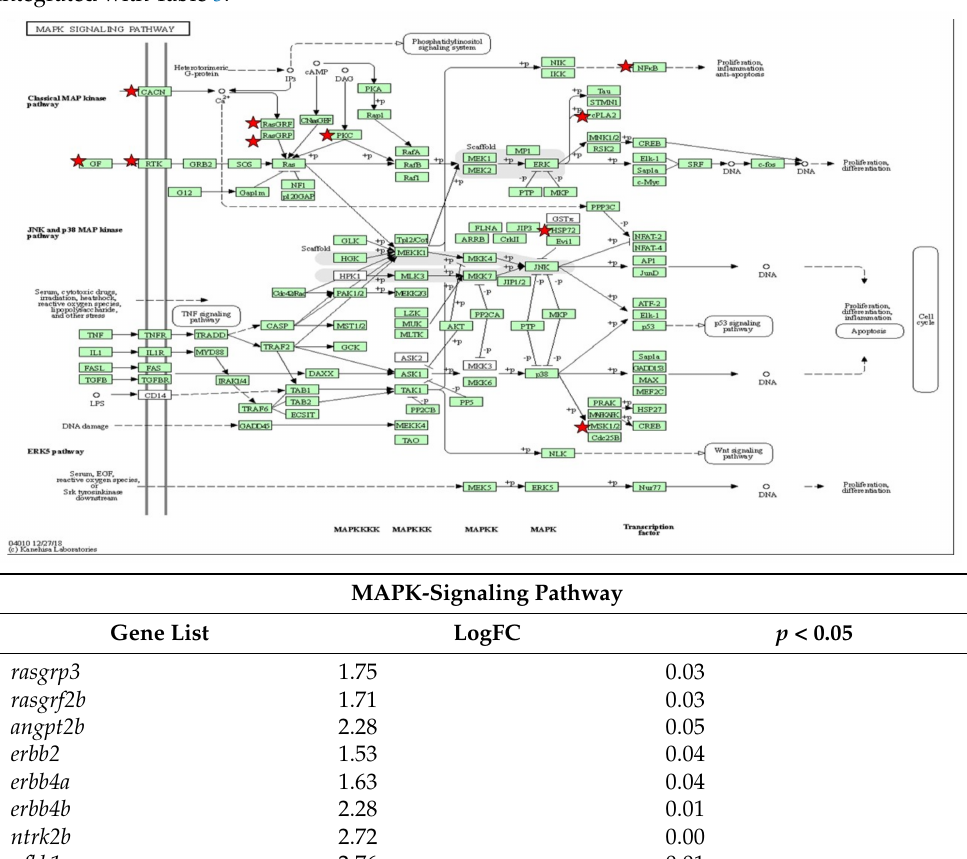
Table 5. The gene set enriched in the MAPK-signaling pathway in the DAVID platform. MAPK- signaling pathway depicted based on KEGG pathway with the significant differential expressions set enriched ( p < 0.05). The star (*) indicates the gene involved in the classical MAP kinase pathway integrated with Table